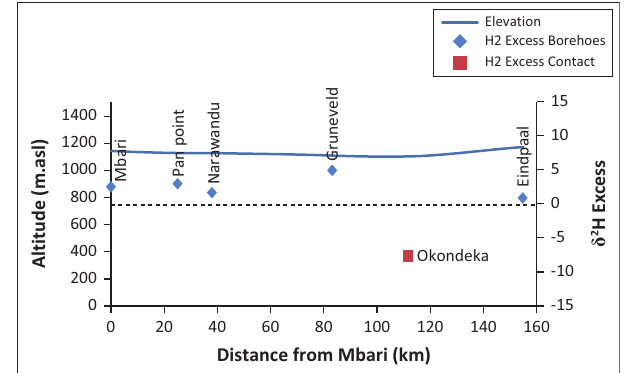
FIGURE 2: Stable isotope results ( δ 18 O/ δ 2 H) for samples of different water point types in the Etosha National Park, May 2013 (Windhoek Meteorological Water Line developed from International Atomic Energy Agency Global Network of Isotopes in Precipitation database